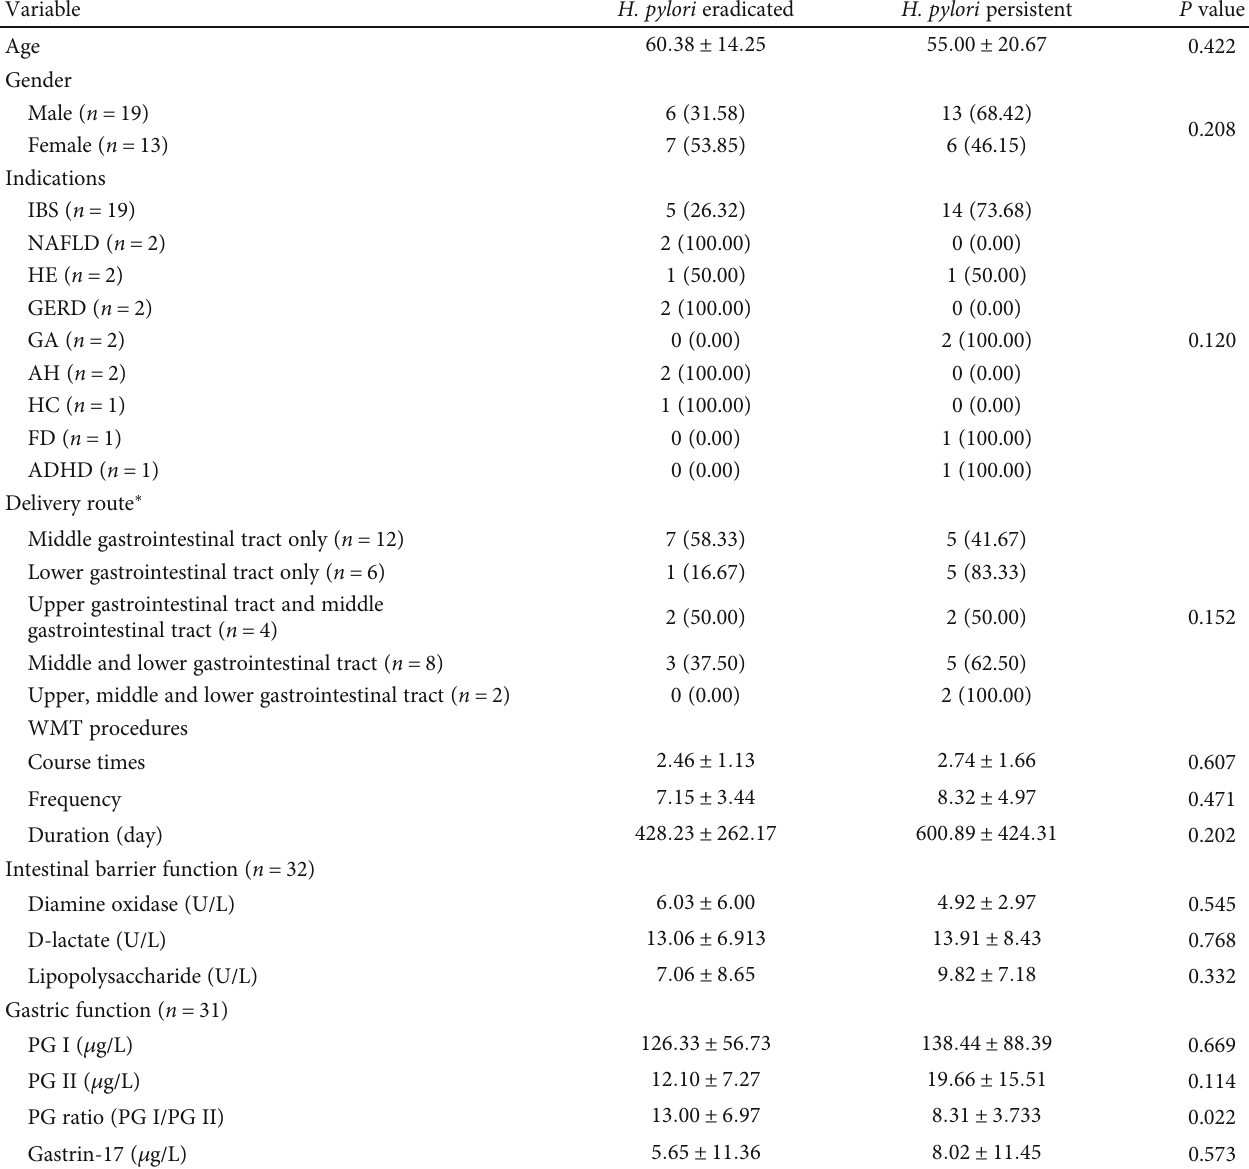
Table 1: Associations of age, gender, indications, and procedures of WMT with H. pylori eradication by WMT.